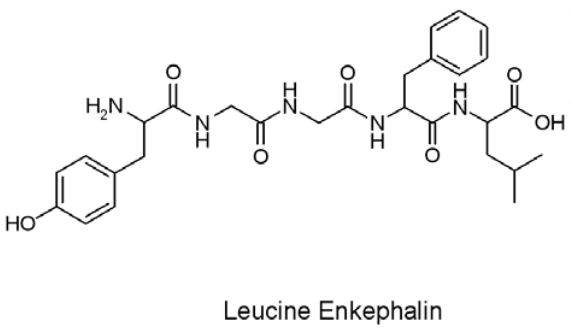
Fig. 1 Structure of